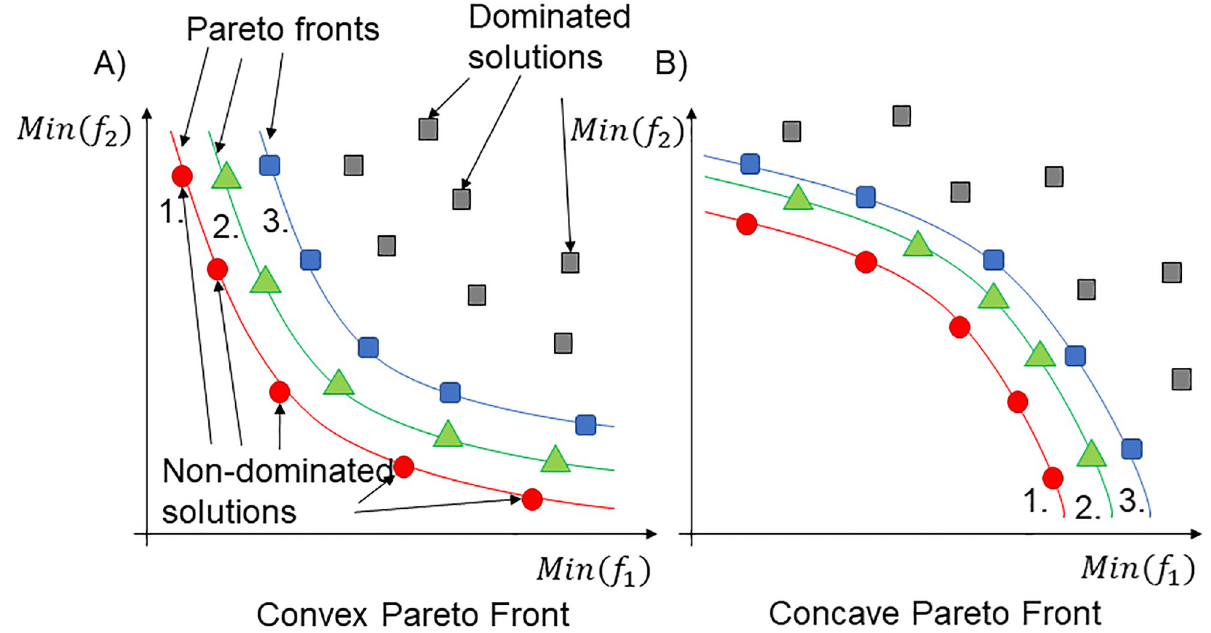
Fig 3. Pareto front representation. Pareto fronts can be convex (A), concave (B), or the mixture of both. Additionally, the set of solutions can have multiple Pareto fronts, which can be identified by ignoring previously determined non-dominated solutions and repeating the search for Pareto fronts. Consider an onion; peel off the first layer to see the second, which will then become the outermost layer. The Pareto front can also be clustered.[34, 35].